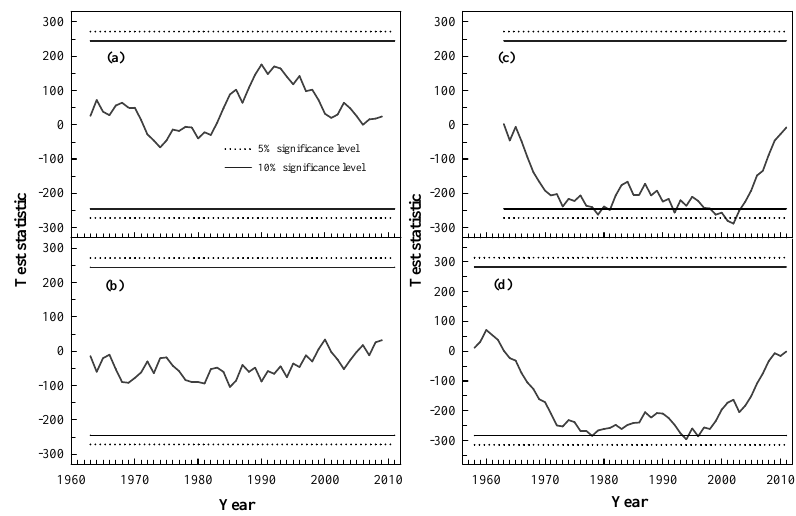
Figure 3. Pettitt’s statistical significance, which was used for detecting change points for ( a ) annual PET; ( b ) annual precipitation; and ( c ) annual streamflow at Wuqi station; and ( d ) annual streamflow at Zhangcunyi station.